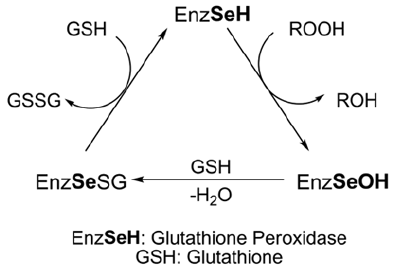
Fig. 2 – Catalytic cycle of gluthathione peroxidases showing the reduction of an organic hydroperoxide.